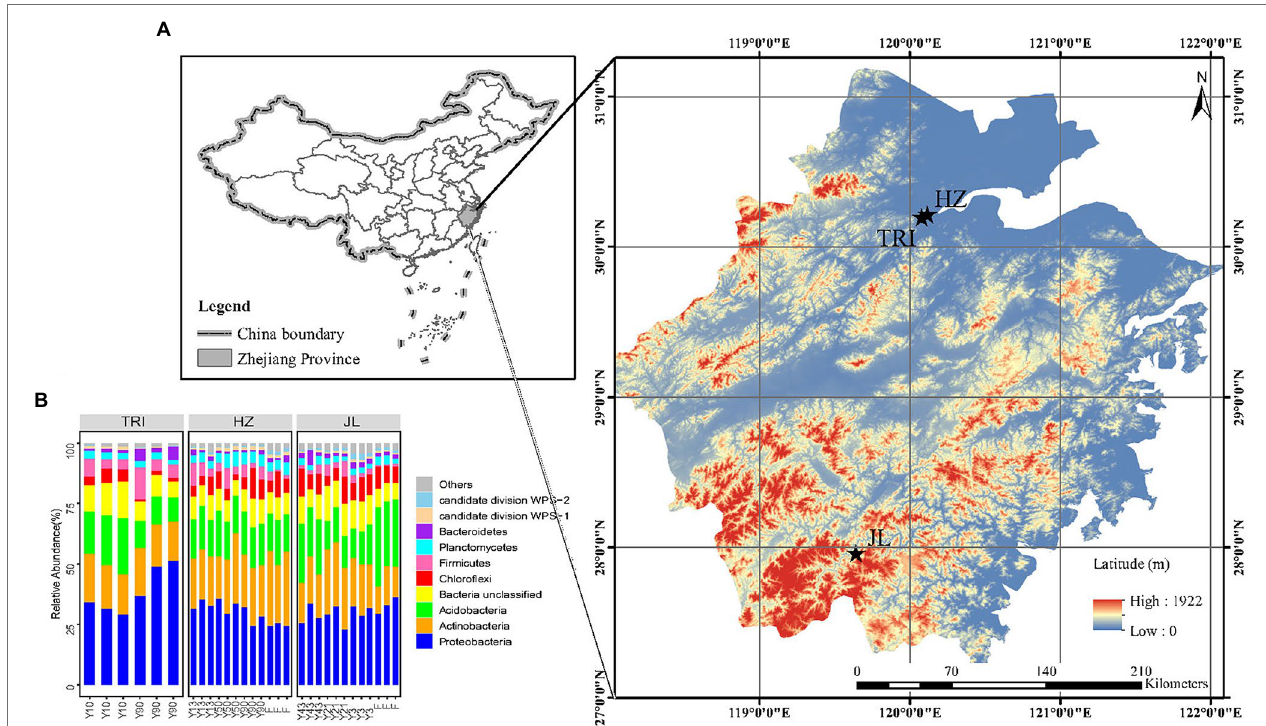
FIGURE 1 | (A) Sampling sites of tea plantations in Zhejiang Province, China (TRI: the Tea Research Institute of the Chinese Academy of Agricultural Sciences; HZ: Wenjiashan village, Hangzhou city; JL: Jingning county, Lishui city). (B) Taxonomic structure of the soil bacterial microbiota at the phylum level. Only the 10 phyla with the highest mean relative abundance are shown, while the other phylum groups are grouped into